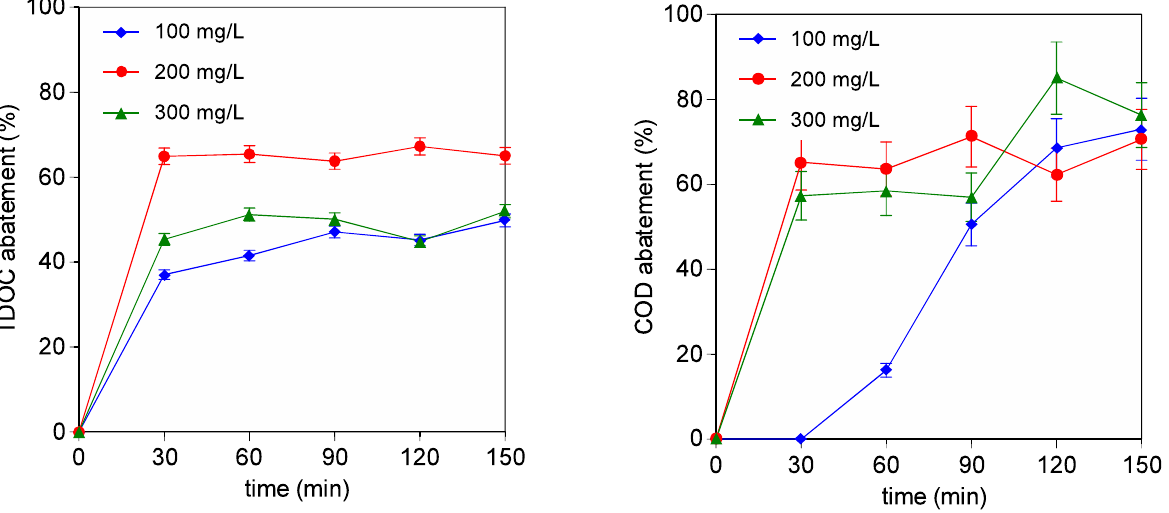
Figure 4. Effect of catalyst dose on TDOC and COD removal efficiencies (reaction condition: 70 ◦ C, pH 5, H 2 O 2 30 mL/L and reaction time 150